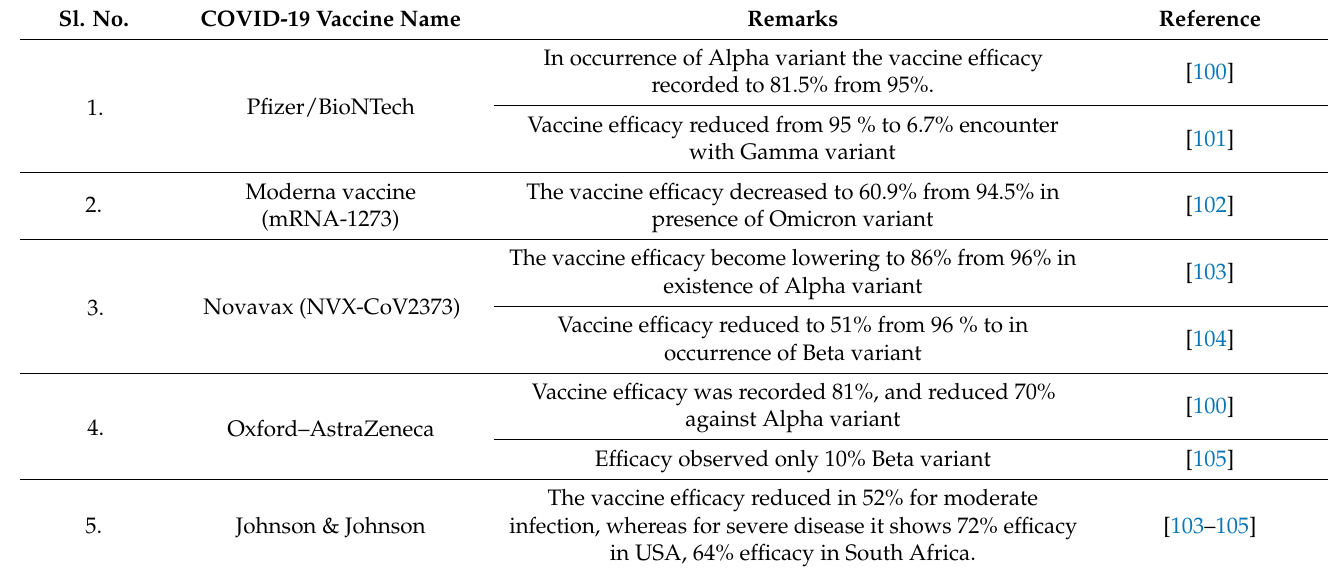
Table 3. Reduced vaccine efficacy of different significant COVID-19 vaccines against SARS-CoV-2 variants. Sl.